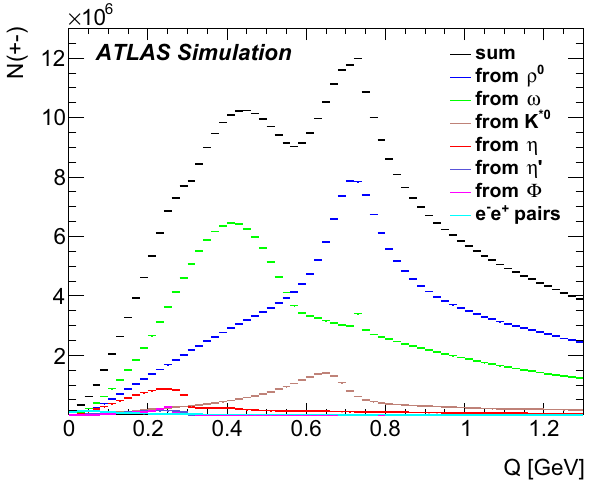
Fig. 16 The inclusive Q distribution of unlike-charge particle pairs for track pairs originating from the decays of various species of single res- onances. The full range of multiplicities contribute to each